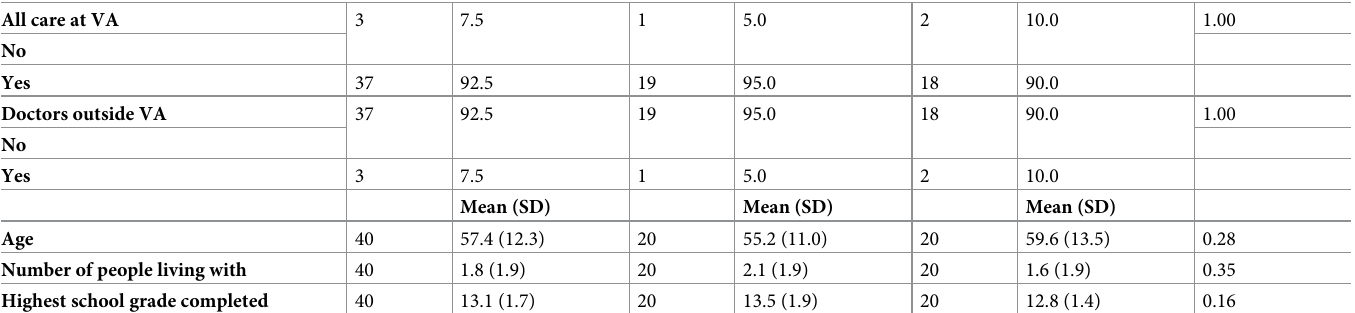
Veterans reported similar levels of chronic pain at baseline, with those assigned to the control arm reporting a mean (SD) pain score of 6.3 (1.5) and those assigned to the intervention arm reporting a mean (SD) pain score of 7.4 (1.4) (Table 4). Although pain scores increased in the control group and decreased in the intervention group, percent change in pain scores from baseline to 12 weeks did not significantly differ between the two groups (Table 5).